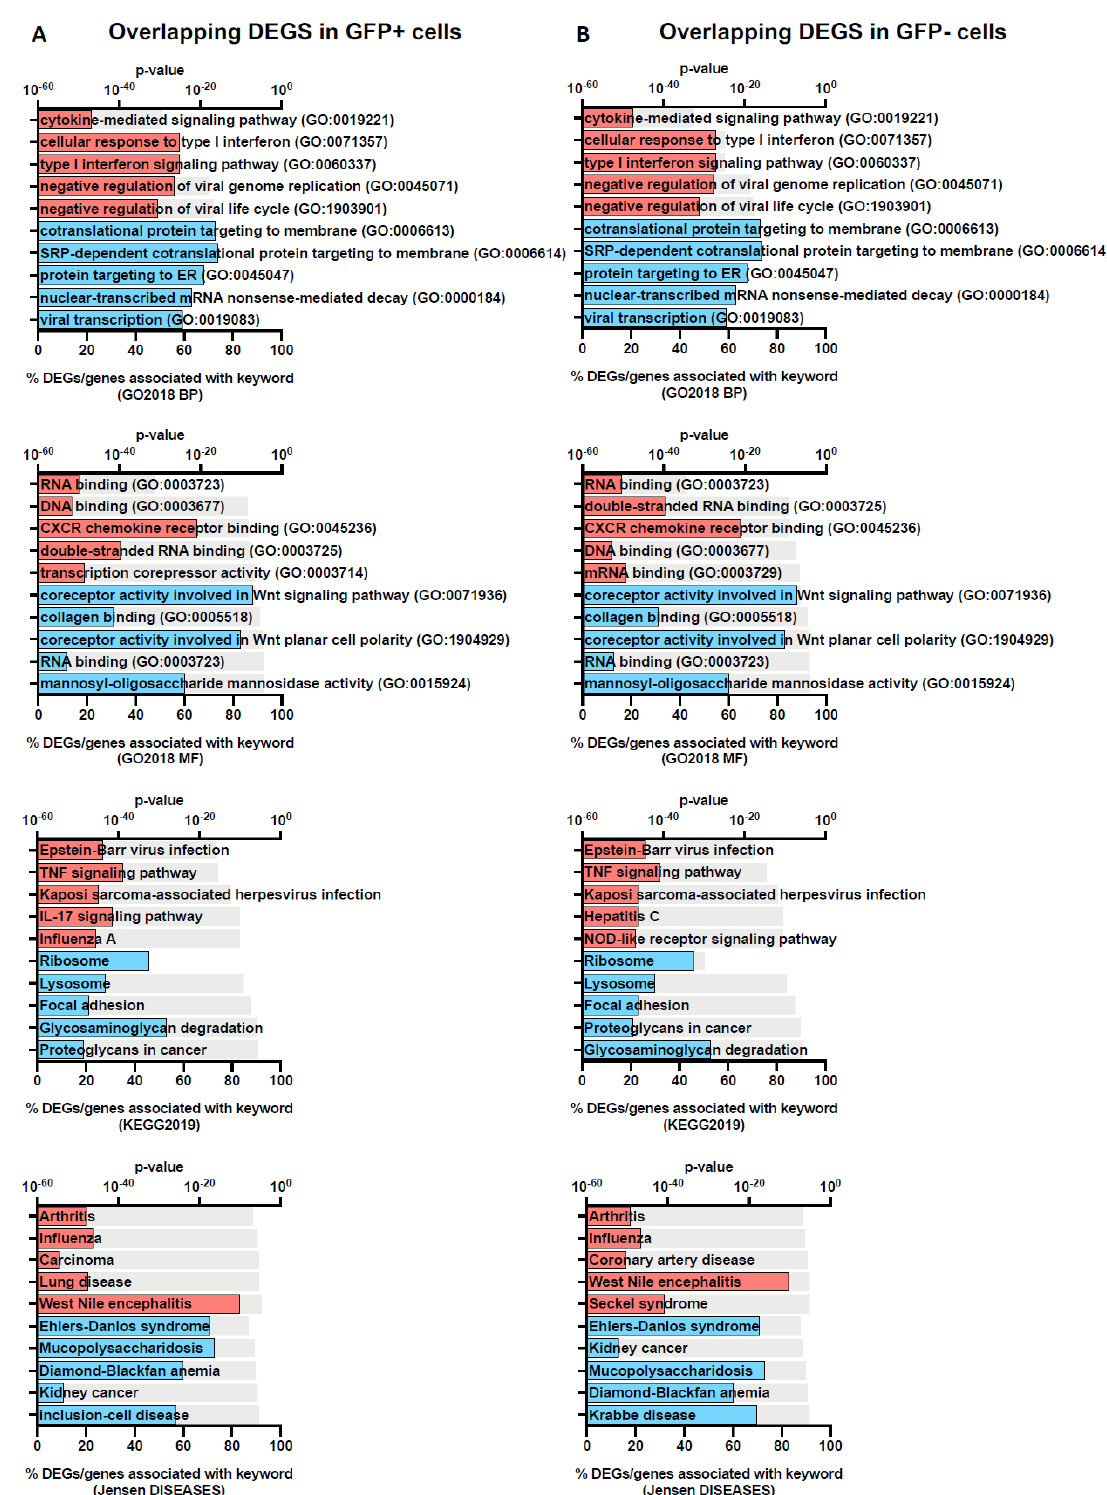
Figure 4. Gene-set enrichment analysis of overlapping DEGs in GFP+ and GFP − populations. The top 5 functional annotation for the two gene profiles: overlap-DEGs-GFP+ ( A ) and overlap-DEGs- GFP − ( B ) were identified using Enrichr with Gene Ontology Biological Process (GO2018 BP) and Molecular Function (GO2018 MF), KEGG and Jensen DISEASES databases. Keywords associated with up- and down-regulated genes are coloured red and blue, respectively. The grey bar represents the p-values determined by the Enrichr analysis